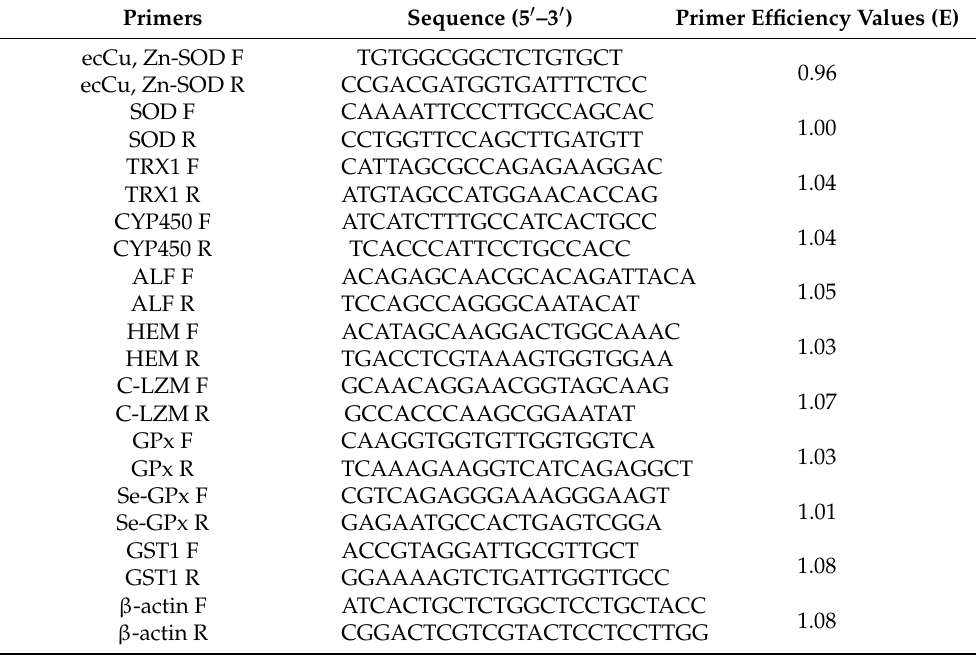
Table 2. Primers used in this study.